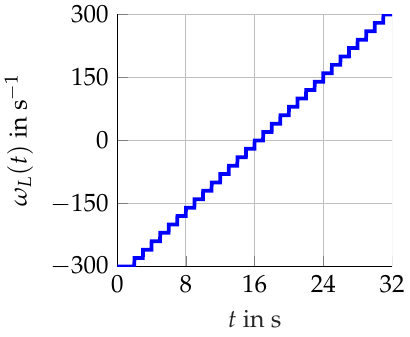
Figure 5. Scenario A for ω L ( t ) representing constant operating points (revolutions per